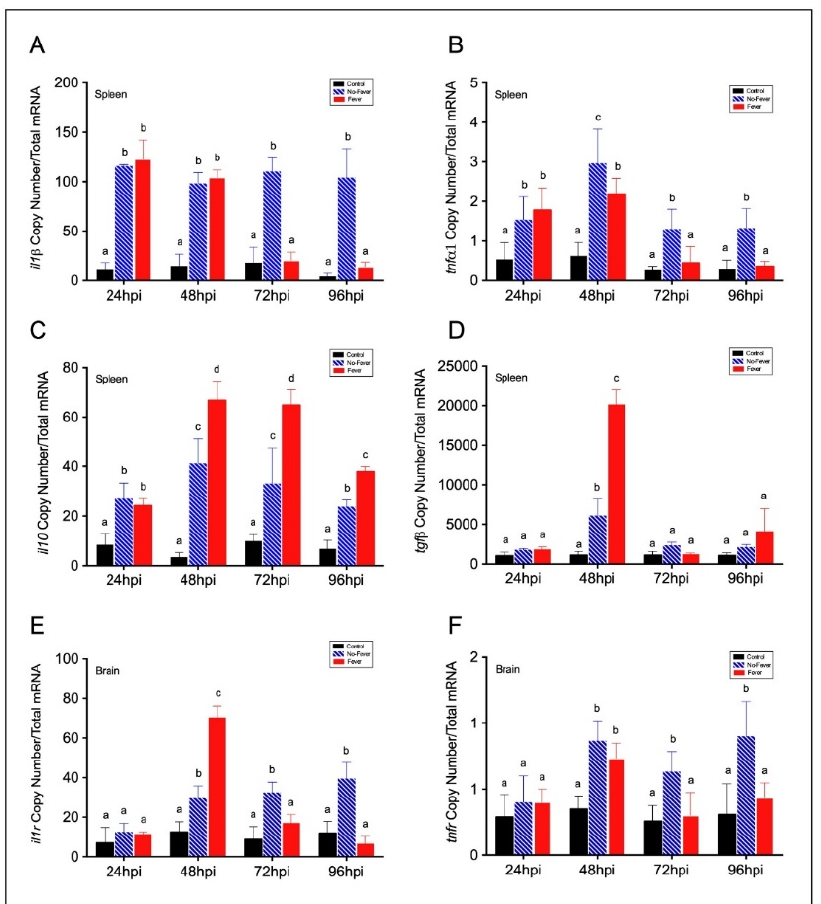
Figure 3. Expression profiles among pro- and anti-inflammatory factors in IPNV-infected fish spleen and brain. ( A – D ) Bar graph showing differences of inflammatory mRNAs abundance between control and IPNV-infected individuals under the thermal treatments. Expression of spleen pro-inflammatory il1 β ( A ) and tnf α 1 ( B ) and anti-inflammatory il10 ( C ) and tgf β ( D ) transcripts in IPNV-challenged fish is shown. ( E , F ) Transcript expression profiles of neural inflammatory cytokines receptors il1r ( E ) and tnfr ( G ). Bar graphs showing the differences between control (uninfected individuals, black bars), no-fever (dashed blue bars), and fever (red bars) individuals (mean ± SD, two-way ANOVA followed by Tukey’s post hoc test, p < 0.01). Different letters denote significant differences. The mean and SD value for the copy number of inflammatory mediators and receptors mRNAs per ng of total RNA is shown. IPNV: infectious pancreatic necrosis virus; hpi: hours post-infection; SD: standard deviation.